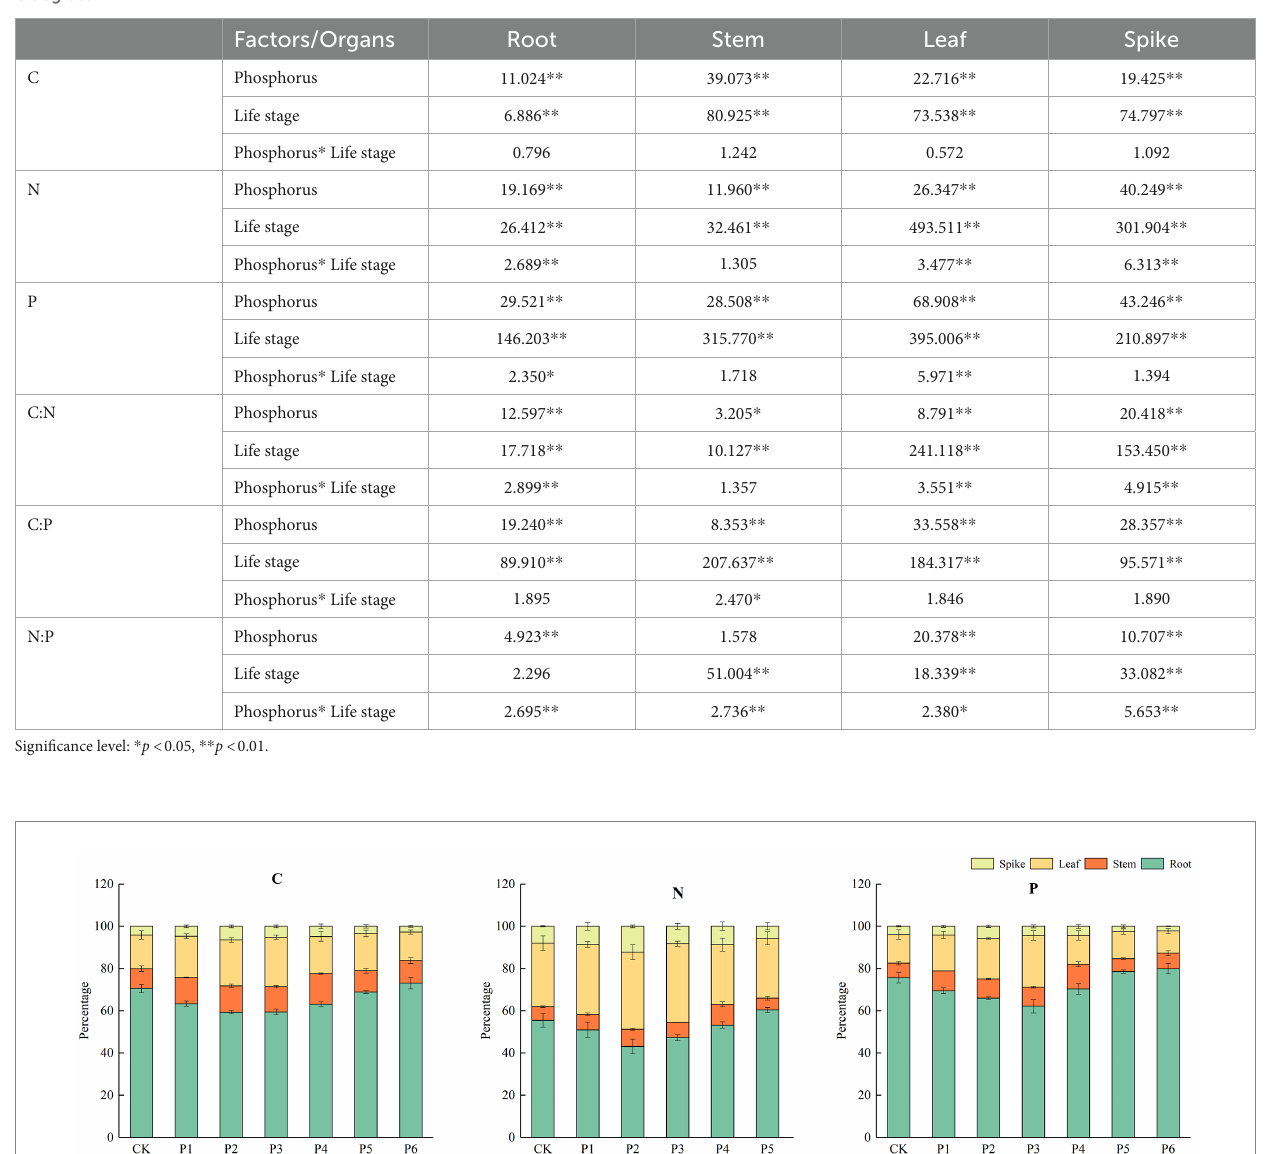
TABLE 1 Two-way ANOVA ( F value) of the effect of increased phosphorus and life stages, and their interaction on organs’ C, N, and P stoichiometry in bluegrass.